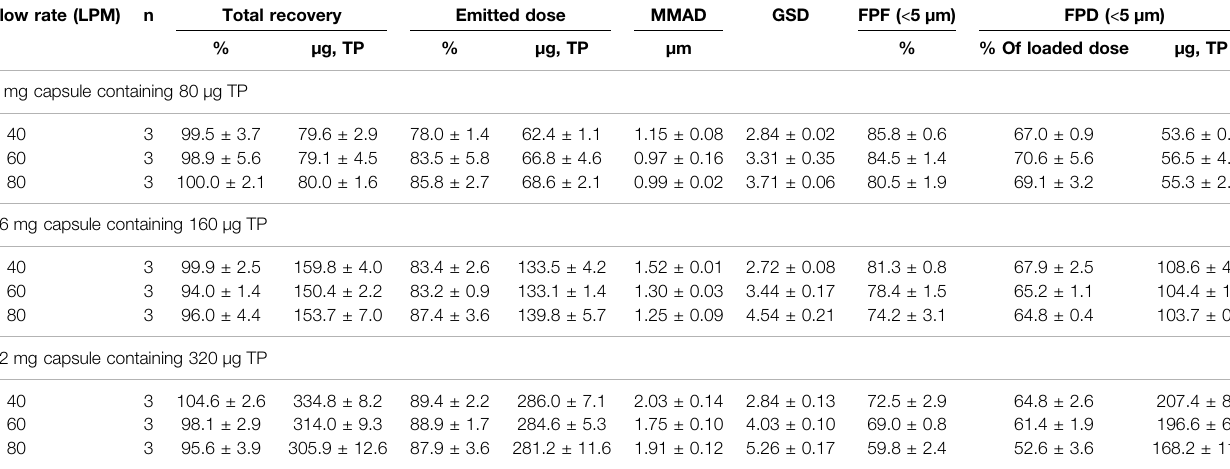
TABLE 3 | TPIP aerosol particle size distribution performance characteristics for the high resistance DPI as a function of fl ow rate. Flow rate (LPM)